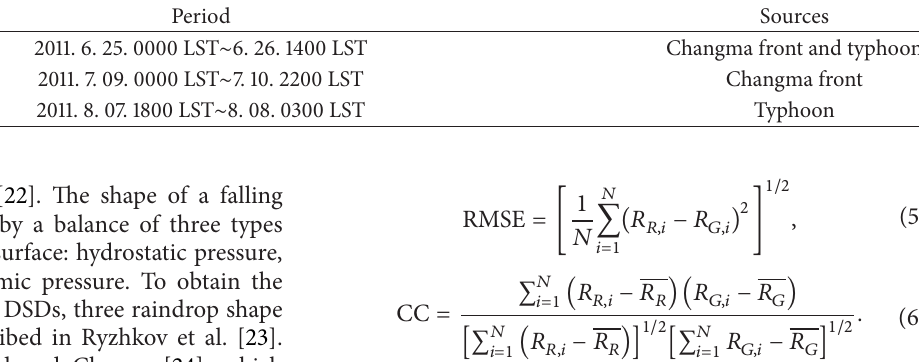
Table 1: Rainfall cases and different source conditions used in the